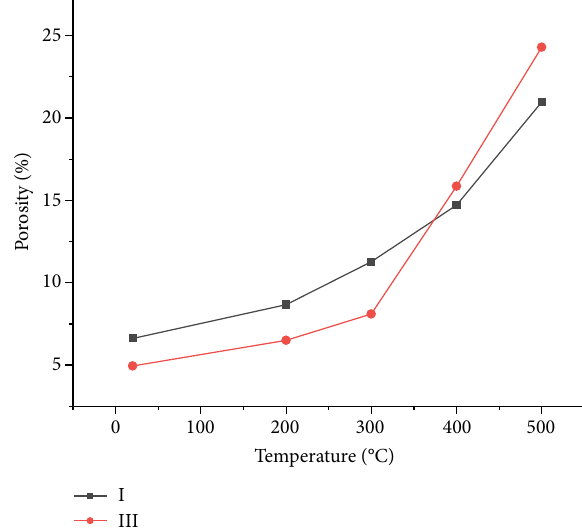
Figure 16: Curve of changes in the porosity of oil